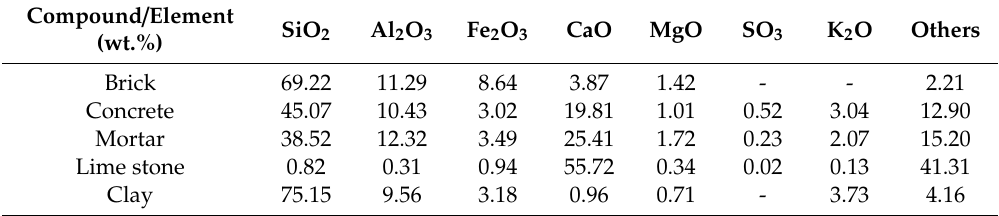
Table 1. Chemical compositions of CDW aggregates and natural limestone.